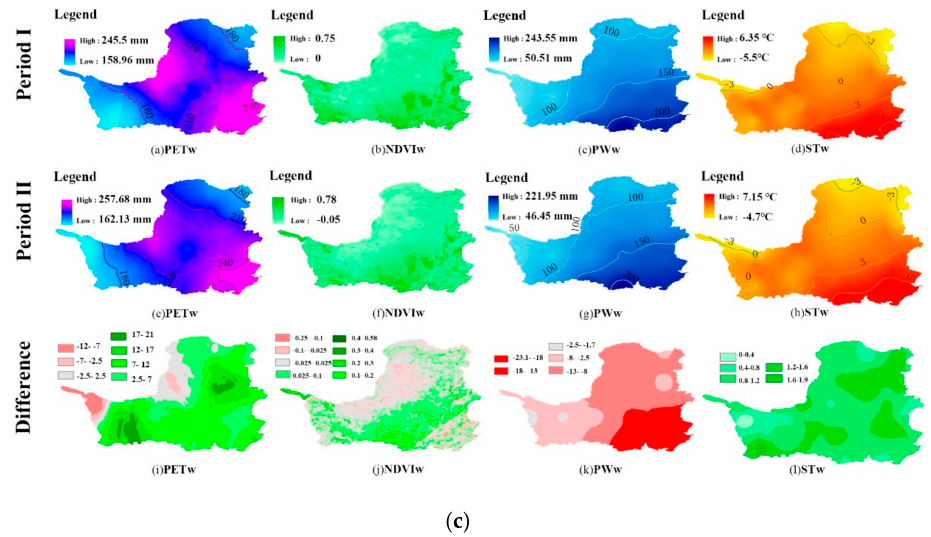
Figure 7. ( a ) The spatial distribution of the annual variation of factors. ( b ) The spatial distribution of the summer (4–9) variation of factors. ( c ) The spatial distribution of the winter (10–3) variation of